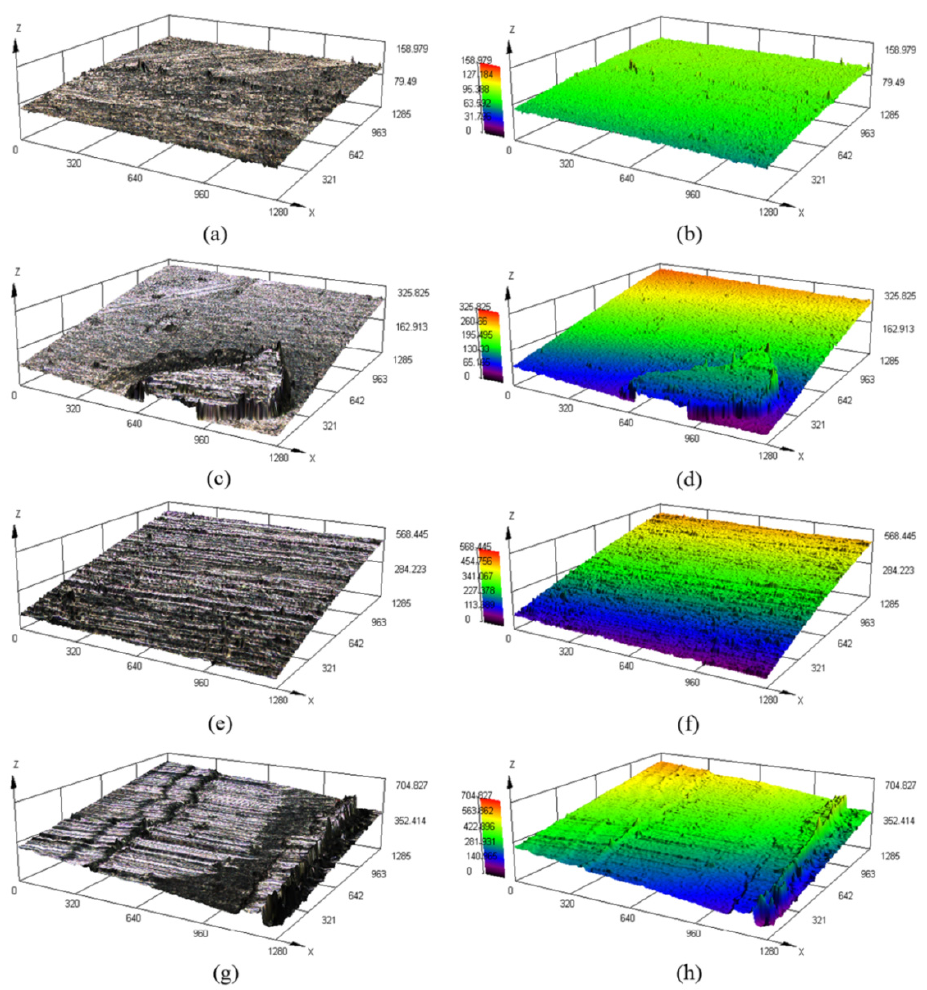
Figure 13. Topography of the tubular outer surface in the assembled camshafts ( a – h ).